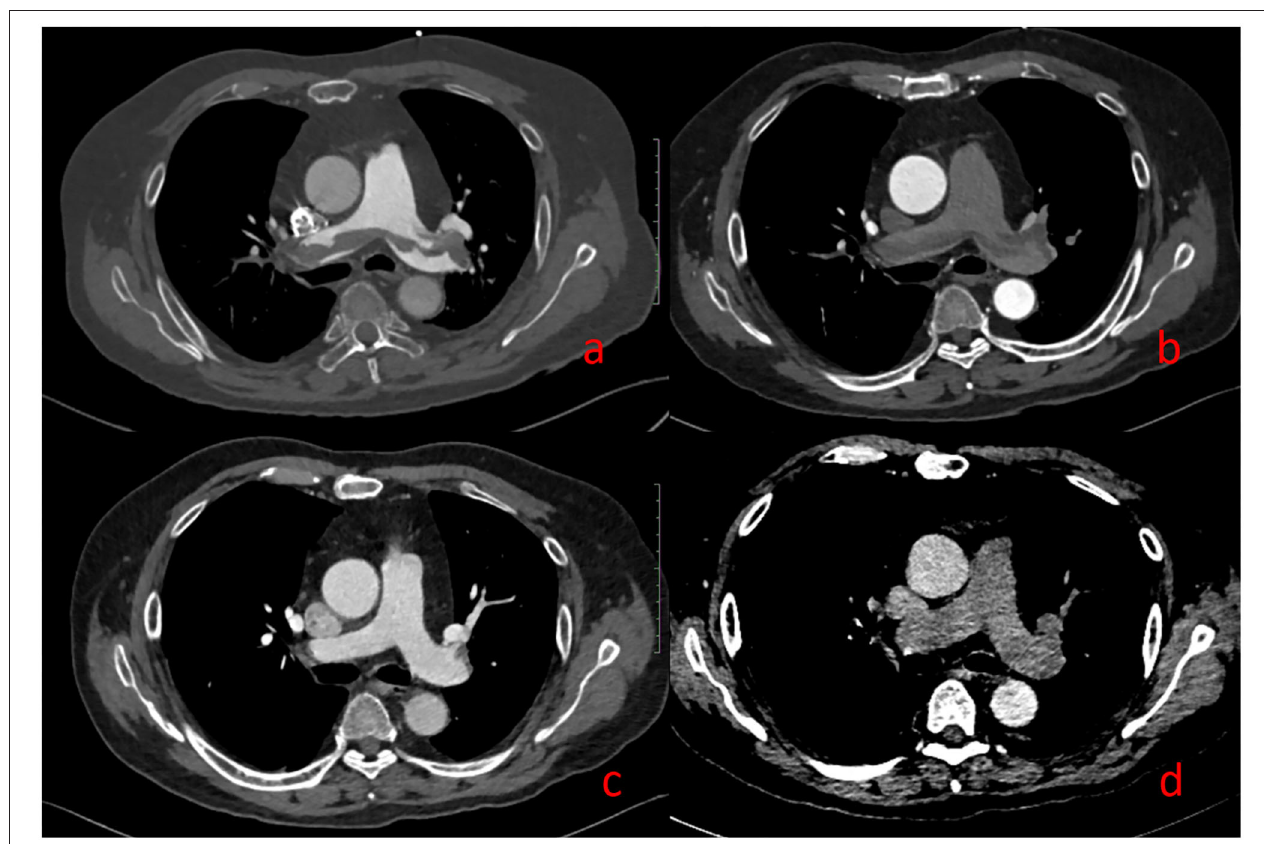
FIGURE 6 | Pulmonary embolism (PE). A 69-year-old man with suspected PE underwent DP-CTPA: Strip filling defects can be seen both in (a) (pulmonary artery phase) and (b) (aortic phase). After thrombolytic therapy, DP-CTPA was reexamined, and the pulmonary artery filling defect has disappeared in (c) (pulmonary artery phase) and (d) (aortic